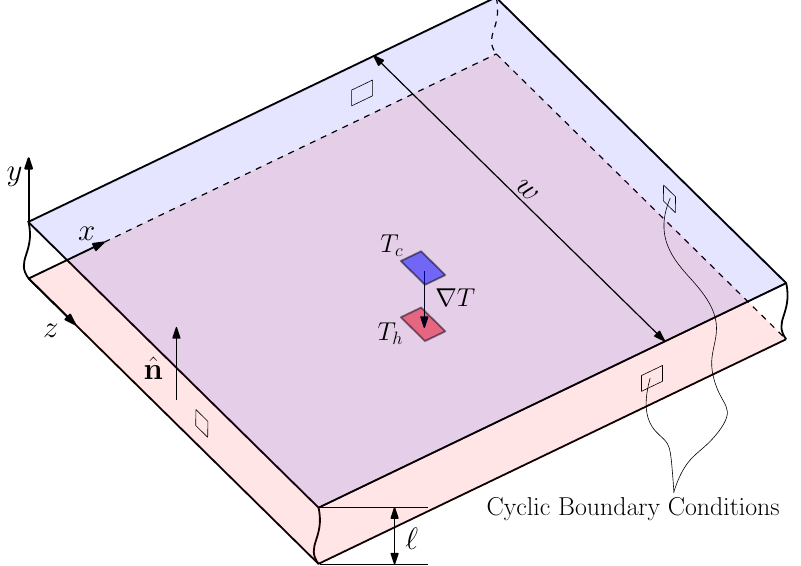
Figure 1. Sketch of the geometry and scheme of the